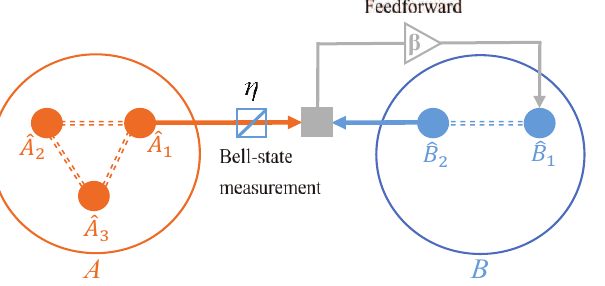
Figure 1. The scheme of the generation of three-mode entanglement. ˆ A 1 , ˆ A 2 , and ˆ A 3 : tripartite entanglement in the cascaded FWM processes A ; ˆ B 1 and ˆ B 2 : bipartite entanglement in a single FWM process B ; η : transmission loss; β : feedforward gain.